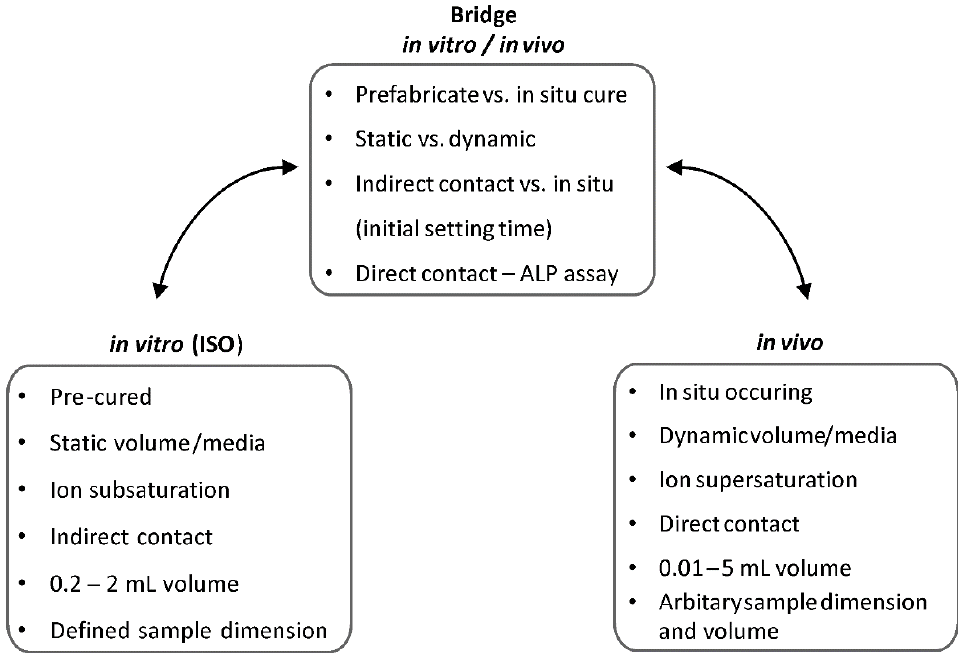
Figure 1. Comparison of common study designs and the present study.